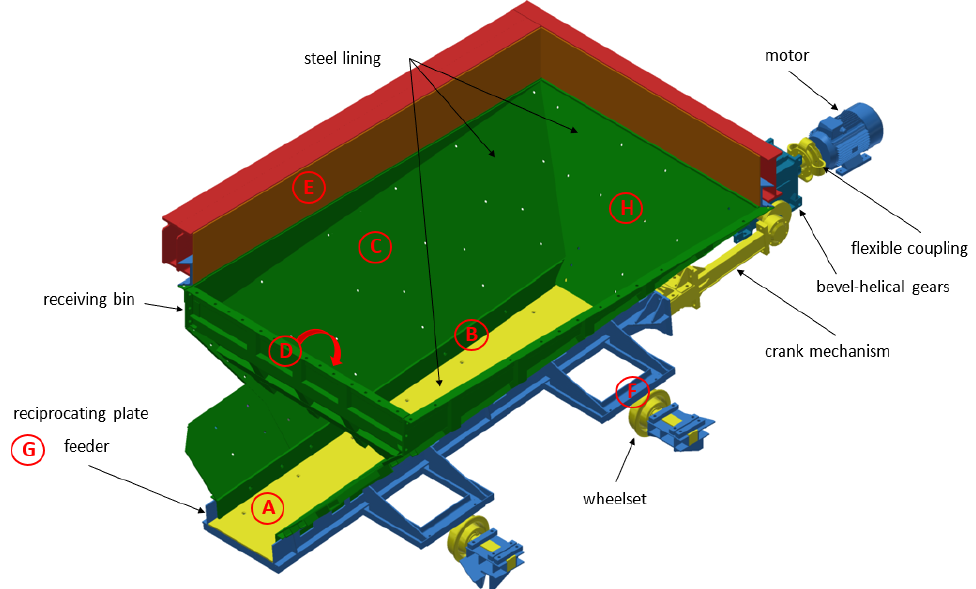
Figure 2. Construction of an ore receiving bin used in Polish copper mines: A—lining of the trough bottom in the reciprocating plate feeder, B—vertical sealing between the reciprocating plate and the fixed hopper, C—lining on the side walls of the hopper, D—lining on the front wall of the hopper, E—crown of the hopper, F—running rail of the feeder trough, G—feeder trough, H—lining on the back wall of the hopper.